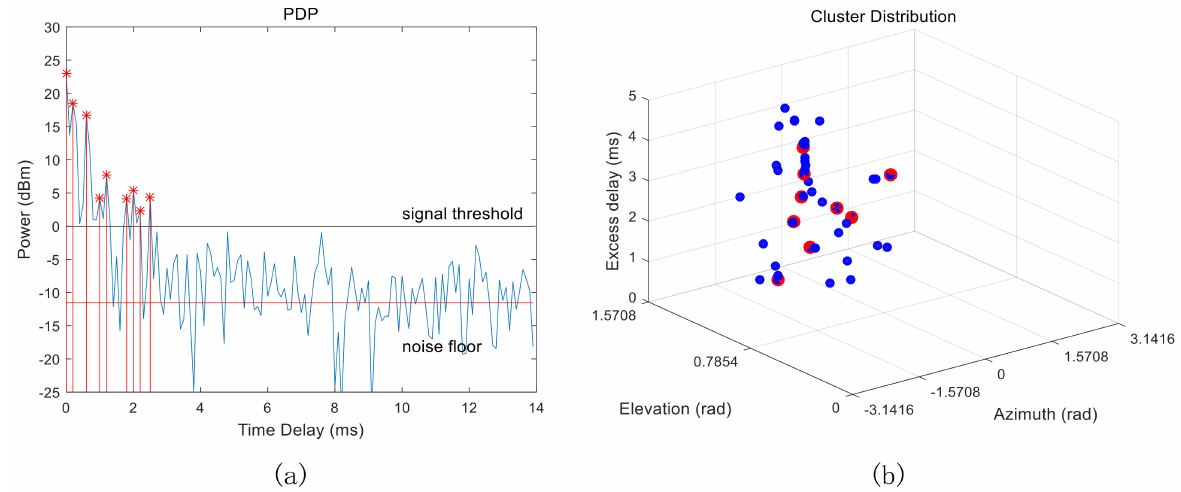
Figure 7. Cluster distribution of antenna element channel. ( a ) The PDP of the channel between No. 1 transmit and No. 1 receive element; ( b ) multipath spatial